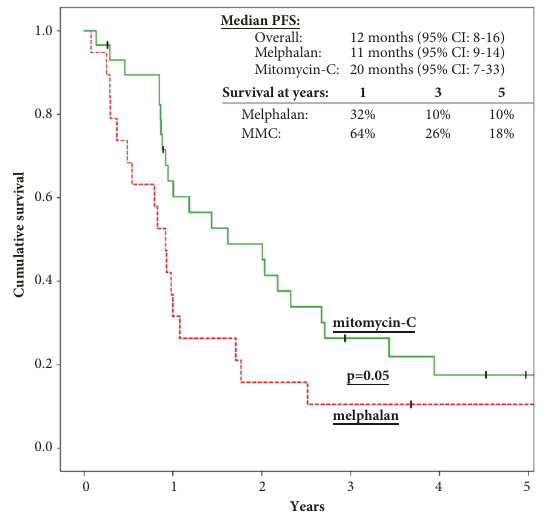
Figure 2: Progression-free survival of patients with PC from CRC treated with